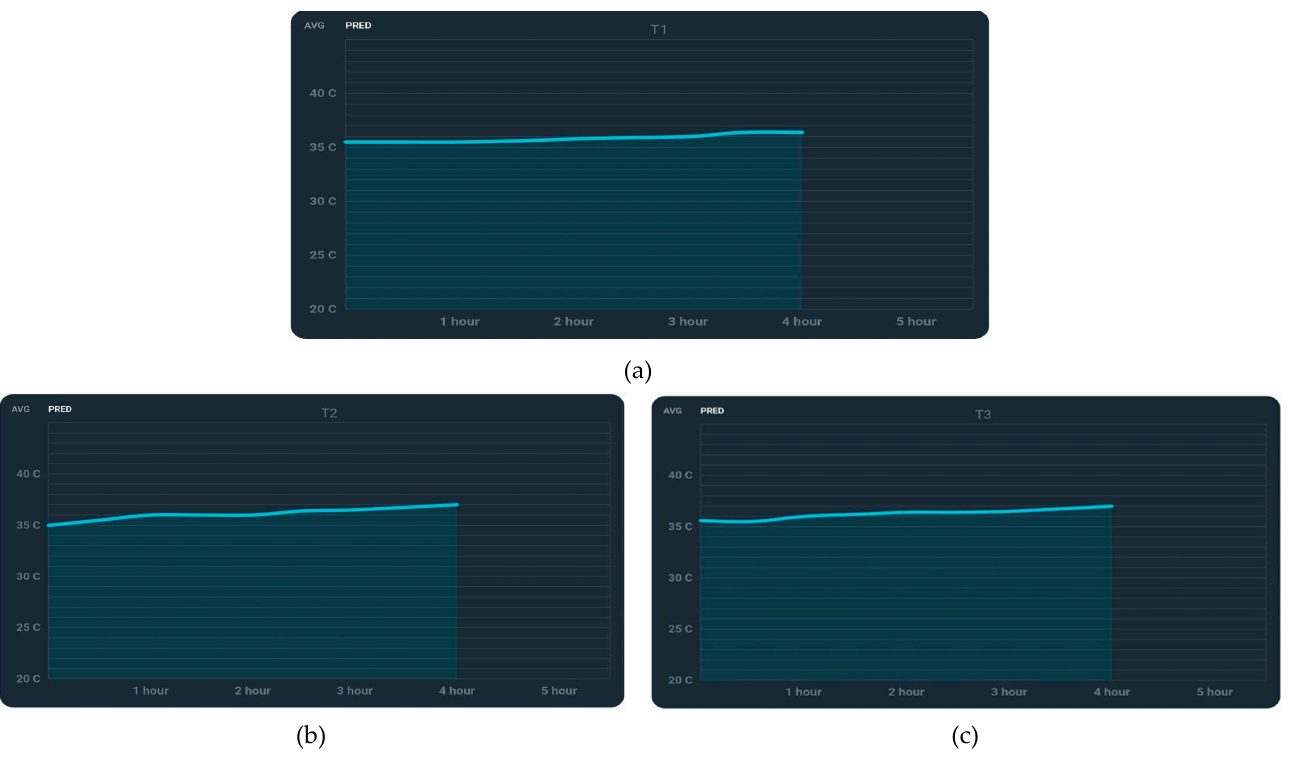
Figure 12. Temperature measurements: ( a ) from location A1, ( b ) from location A2, and ( c ) from location A3. For comparison purposes, results of the volunteer with sacral ulcer are previewed.